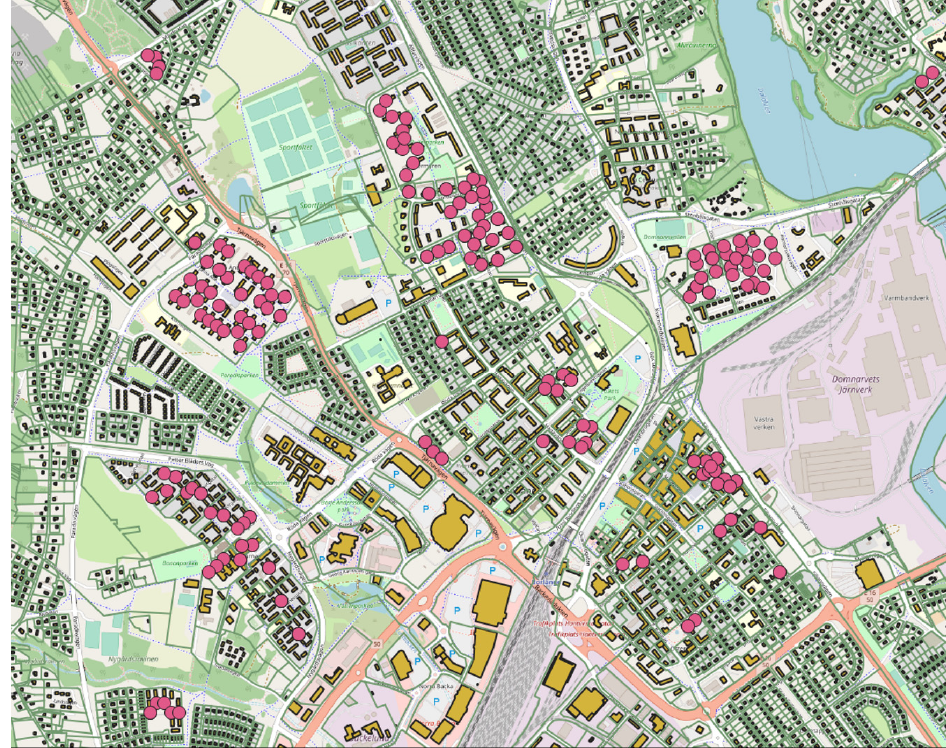
Figure 3. Geodata: building property vectors with adjusted coordinates.